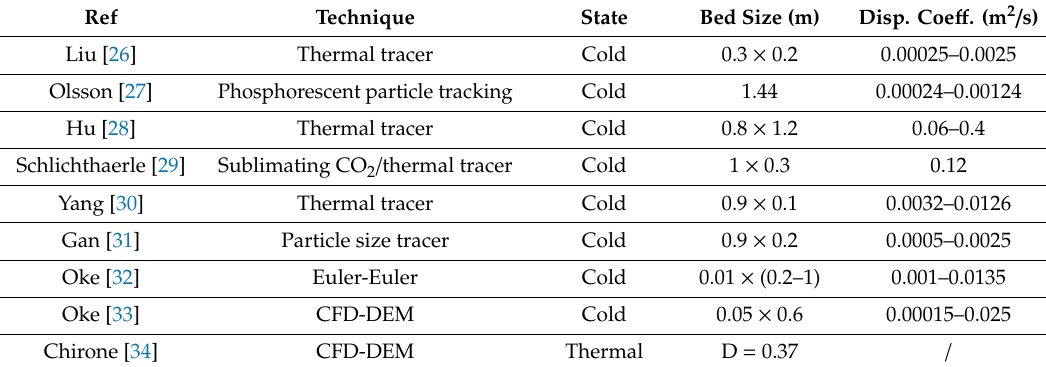
Table 1. Some work predicting the lateral dispersion coe ffi cient of solids in fluidization